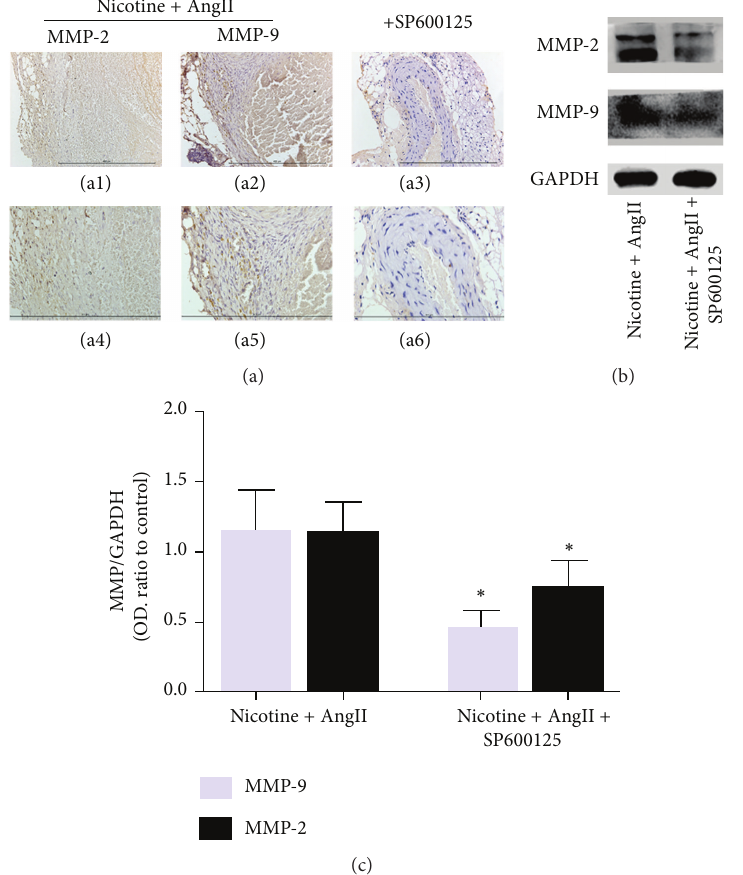
Figure 3: SP600125 suppresses the production of MMP-2 and MMP-9 in aortic tissue. (a) Representative images of immunohistochemical staining showing that MMP-2 and MMP-9 proteins are abundant in nicotine plus AngII-induced AAA tissues (a1, a2, a4, and a5), where they appear to be localized in the medial and outer smooth muscle cells. SP600125 downregulated the production of MMP-2 and MMP-9 in AAA lesions (a3 and a6). (b, c) Representative western blots for MMP-2 and MMP-9 revealing that SP600125 inhibits the expression of MMPs. The band optical density (OD) values (mean ± SD) of MMP-2 and MMP-9 were evaluated with ImageJ. GAPDH was used as an internal control and results are from independent triplicate experiments. ∗ refers to 𝑃 < 0.05 versus